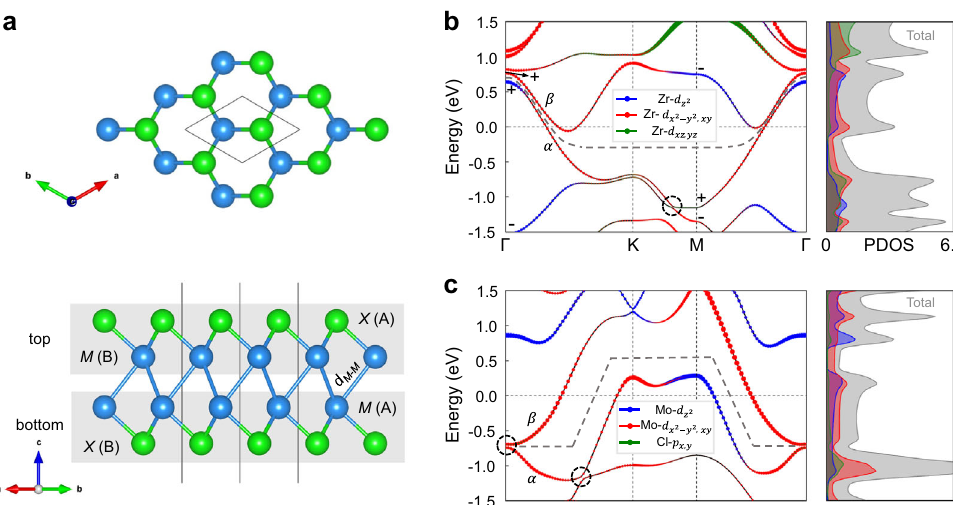
Fig. 1 Atomic and electronic structures. a Crystal structure of monolayer transition-metal monohalides MX ( M = Zr, Mo; X = F, Cl) with two (top and bottom) M - X sub-monolayers. Orbital-weighted band structures with spin-orbit coupling (SOC) and projected density of states (DOS) of b monolayer ZrCl and c monolayer MoCl. Here, + ( − ) denote parities. The two bands with crossing the Fermi level are labeled as α and β . The gray dashed lines exhibit the curved Fermi level, and the black dashed circles show SOC gaps at Dirac-type crossings (i.e., crossing points without